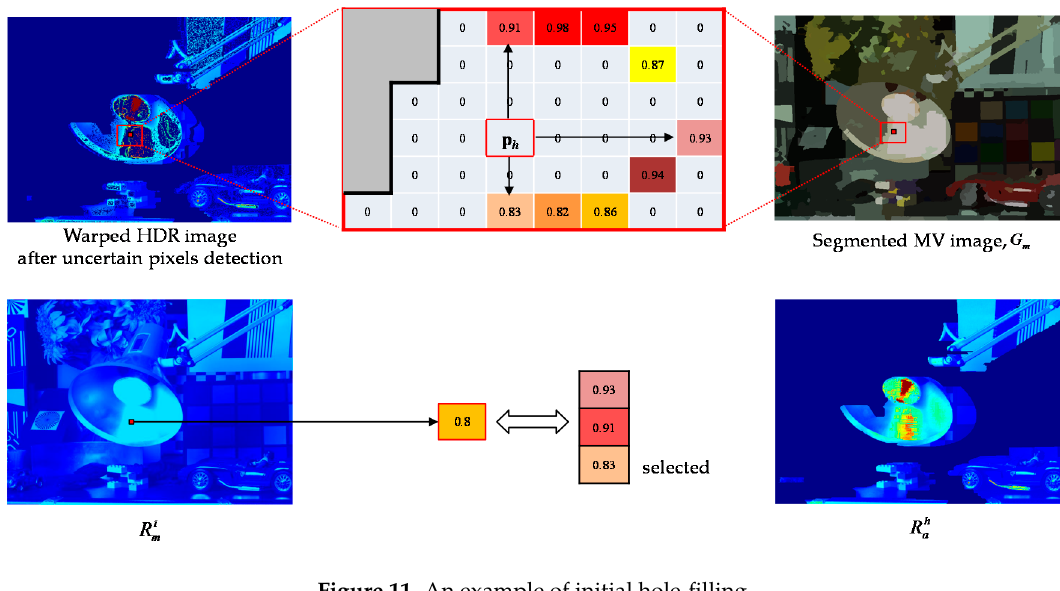
Figure 11. An example of initial hole-filling.